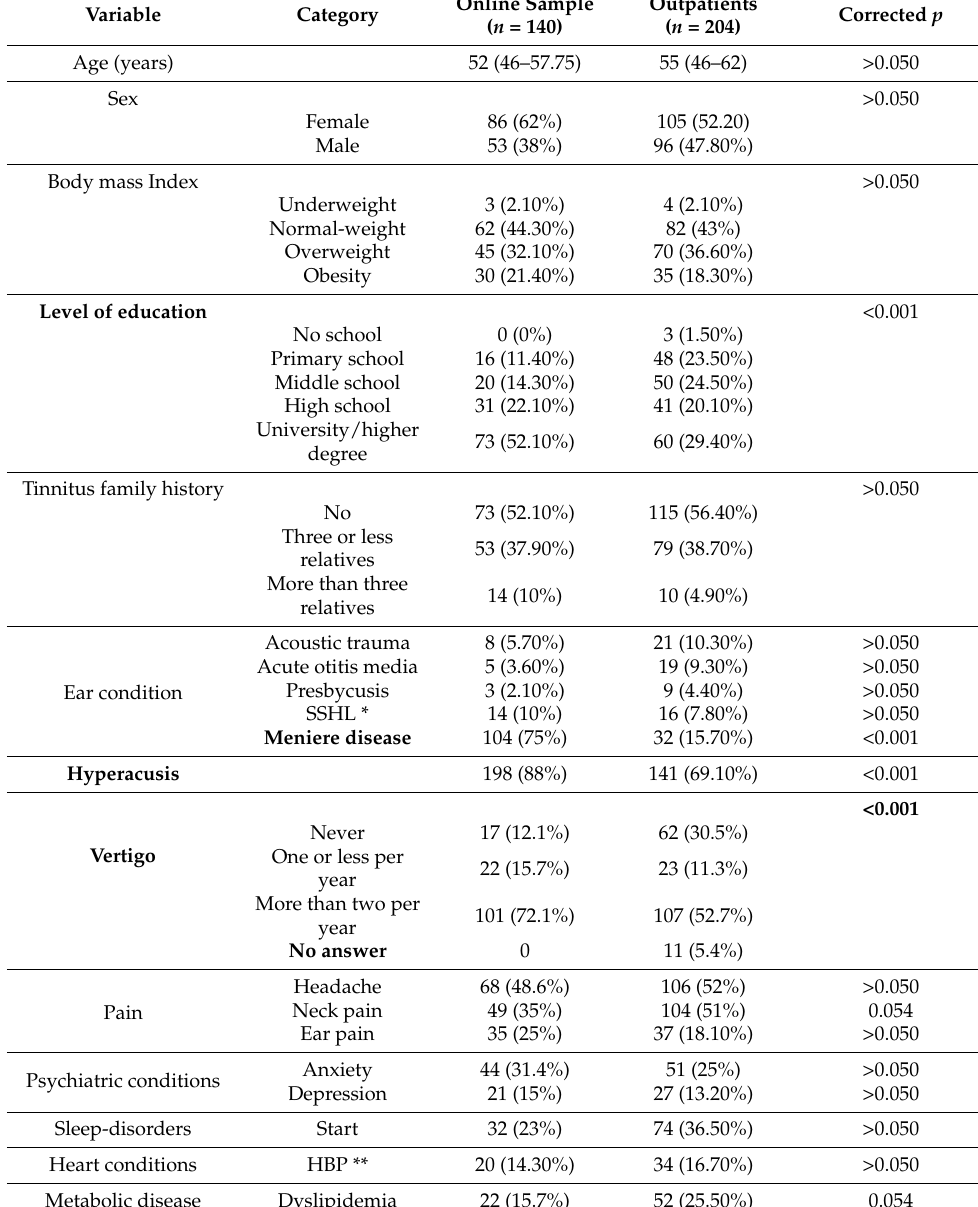
Table 3. Demographic data and comorbid conditions in patients with chronic tinnitus after adjusting for sex and age ( n =